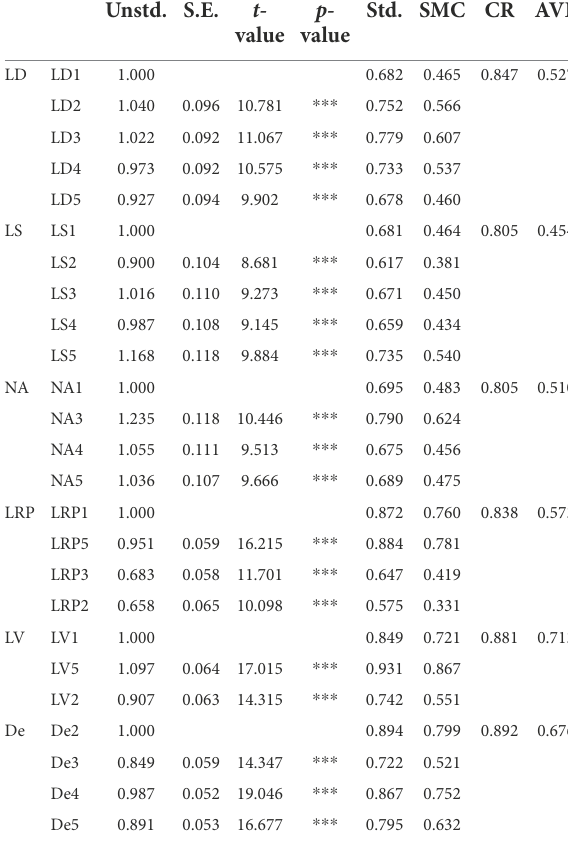
TABLE 7 Convergent validity test results.